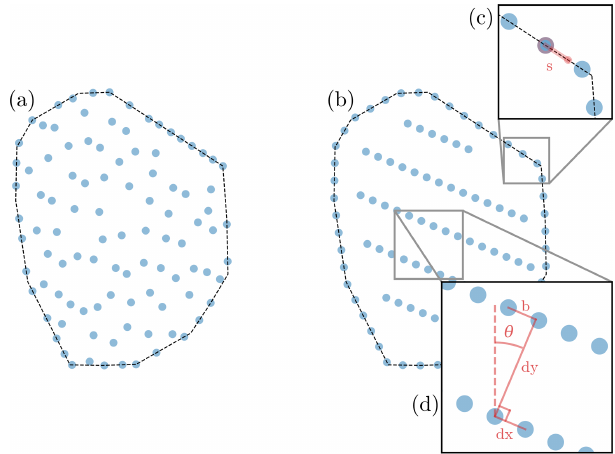
Figure 3. Example 100-turbine wind farm layouts, and parameter- ized wind turbine layout definition. Each dot is to scale, represent- ing the wind turbine diameter. (a) Wind farm layout when the posi- tion of each turbine has been optimized directly. This optimization required 200 design variables – the x and y location of each turbine. (b) Wind farm layout optimized with boundary-grid parameteriza- tion. This optimization required five design variables, shown in pan- els (c) and (d) . (c) The start location design variable, s . (d) The four variables defining the inner grid: the grid spacing, d x and d y , the grid offset b , and the rotation, θ